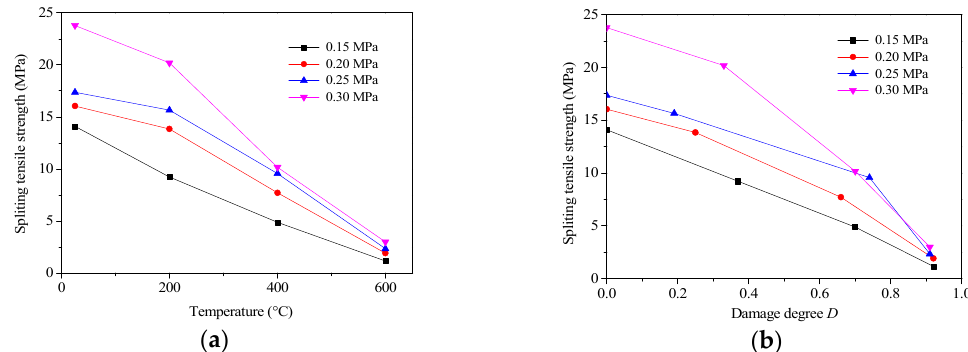
Figure 9. The relationship between ( a ) the splitting tensile strength and temperature; and ( b ) the dynamic splitting tensile strength and damage degree.